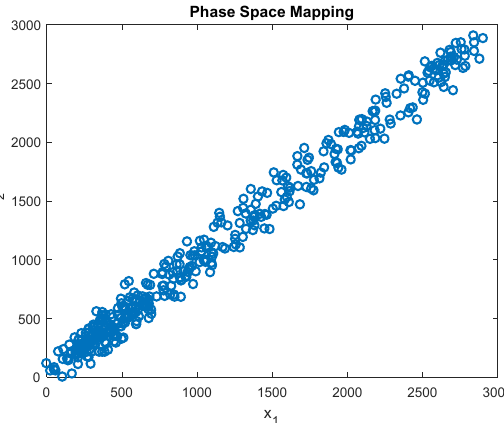
Fig. 4. A phase space mapping for suitable lung volume.